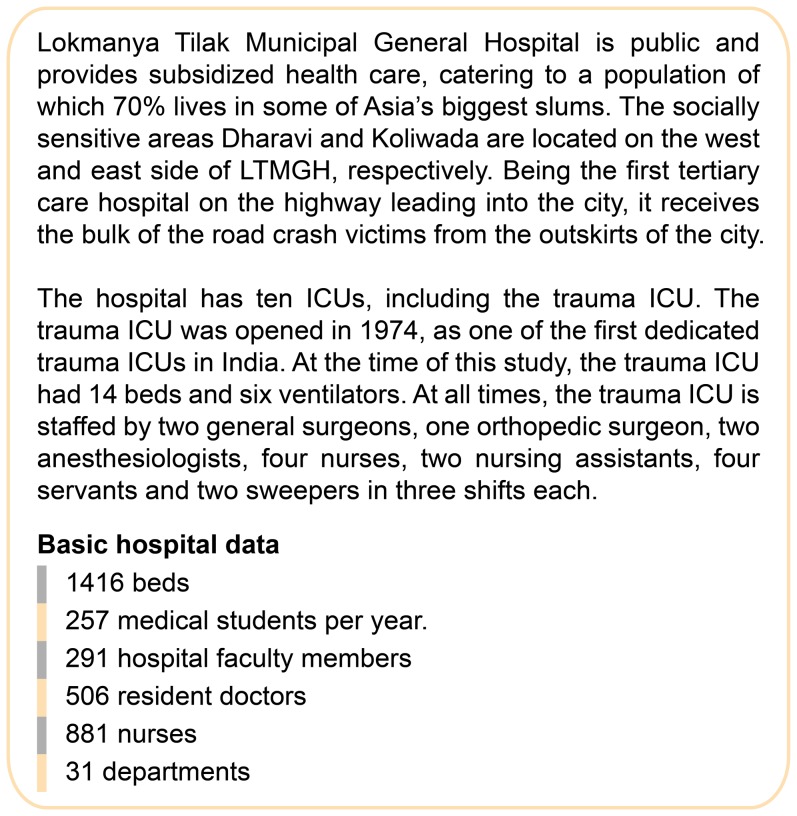
Characteristics of Lokmanya Tilak Municipal General Hospital.Abbreviations: ICU Intensive Care Unit.